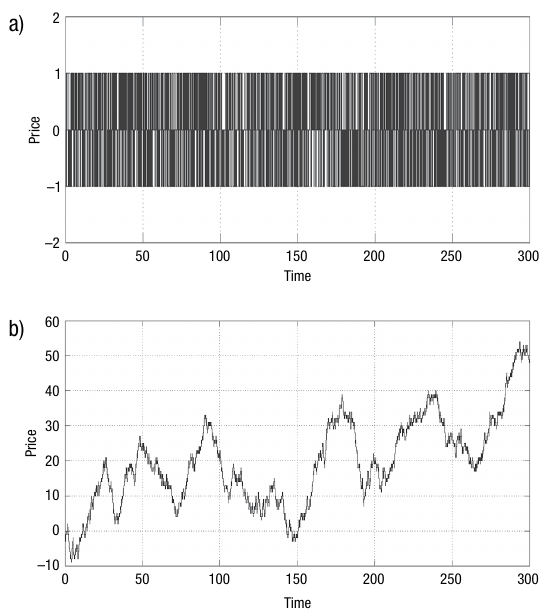
Fig. 5. Series of independent steps (simulated path 3)